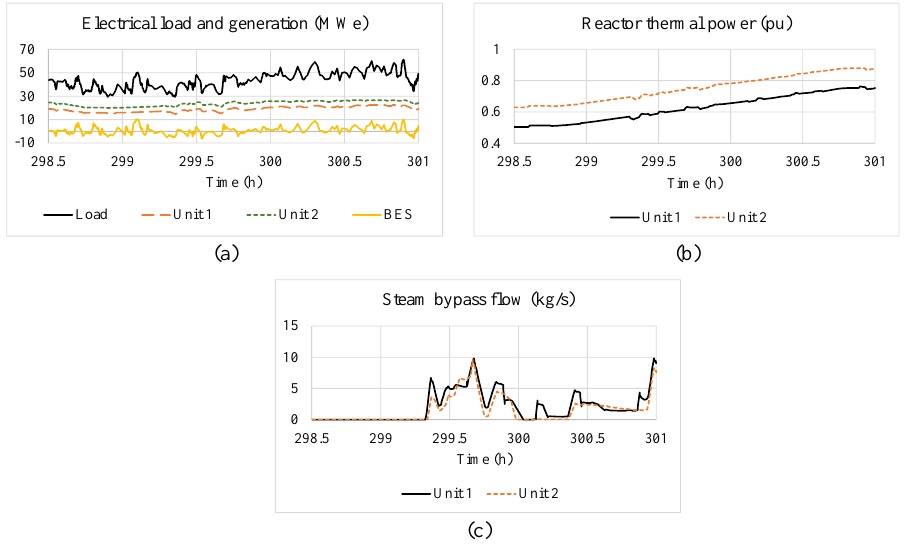
Figure 10. Dynamic simulation results of 2.5 h period between 298.5 h and 301 h: ( a ) electrical load and generation; ( b ) reactor thermal power; ( c ) steam bypass